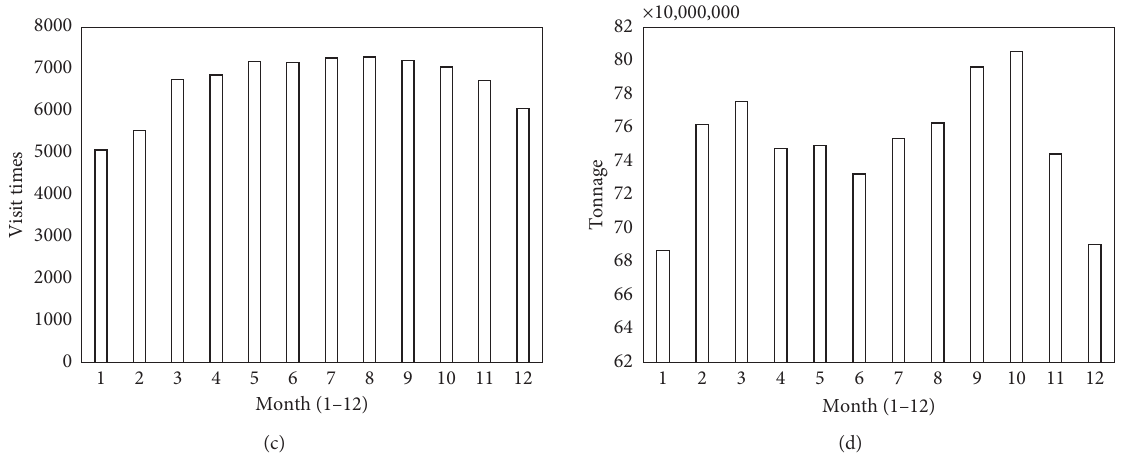
Figure 3: Periodical vessel visits and flows. (a) F visit by date. (b) F weight by date. (c) F visit by month. (d) F weight by